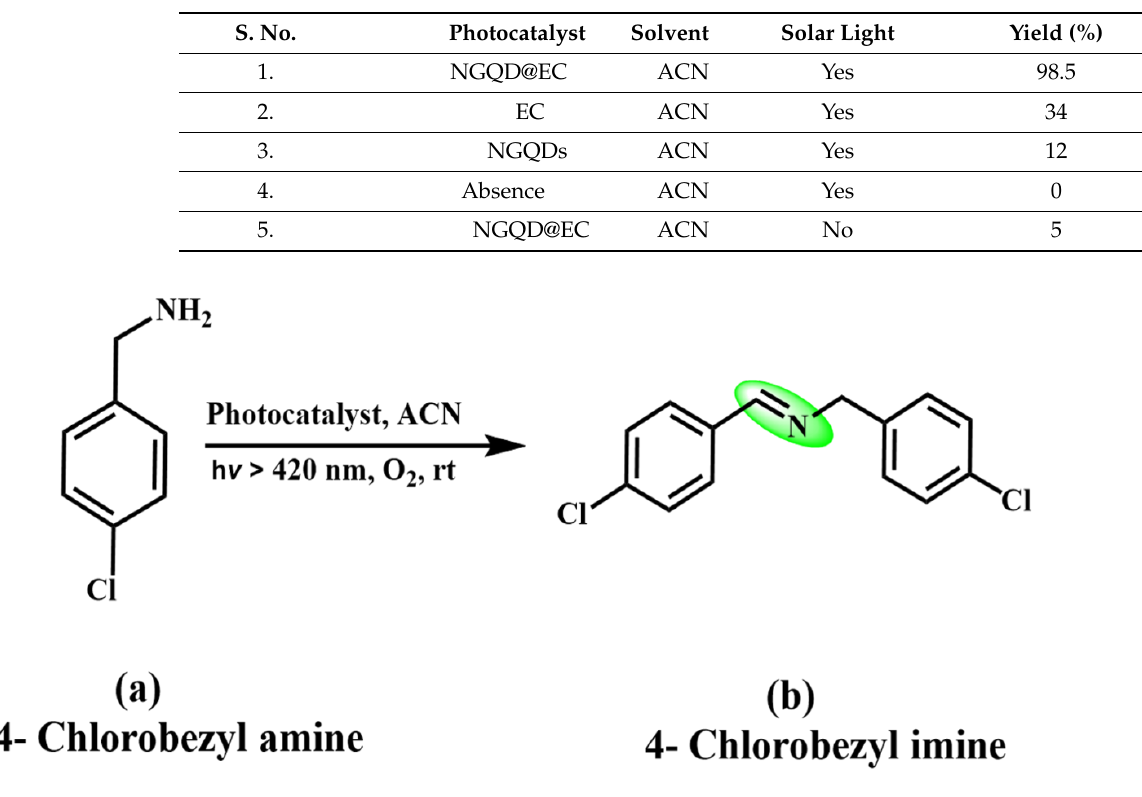
Table 1. Results of screening experiments. S.